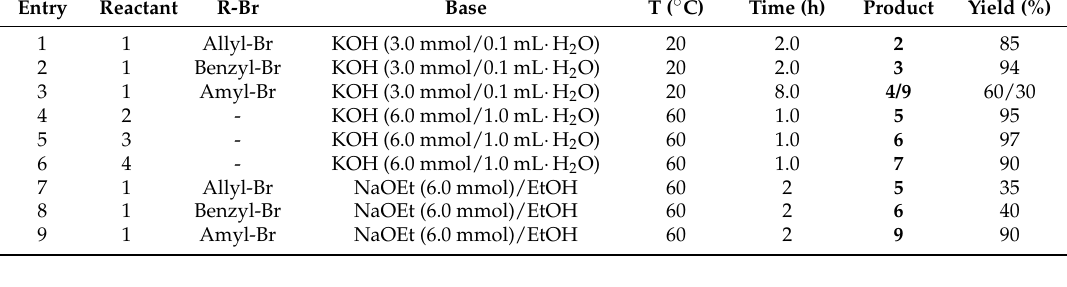
Scheme 2. Reaction of indol-2-carbohydrazide 10 with aldehydes and ketones.